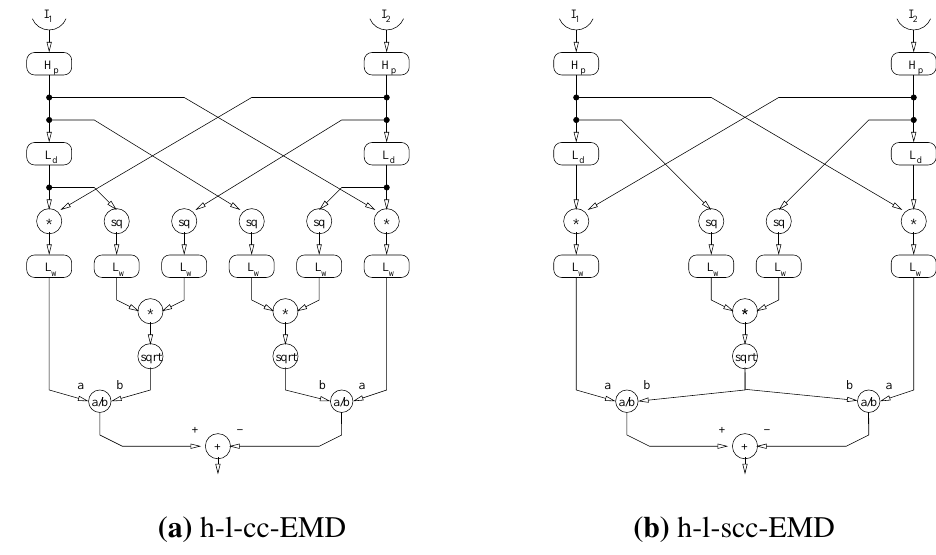
Figure 2. Augmented variants of elementary motion detectors. The input signals ( I , I ) originating from neighbouring points in space pass through different combinations 1 2 of high-pass filter (H) and low-pass filter (L). In the next step, the differently filtered signals of the neighbouring inputs are multiplied ( ∗ ) and afterwards a contrast normalisation is performed ( a/b ). The normalisation consists of a combination of square (sq), square root (sqrt) and low-pass filter. For the h-l-cc-EMD (a) the normalisation is based on the equation for the approximated correlation coefficient (see Equation 4). For the h-l-scc-EMD (b) this normalisation is simplified (see Equation 6). In a last step the signals from the mirror-symmetrical subunits of an EMD (which are most sensitive to opposite directions of motion) are combined. The simplest way is to subtract the signals from each